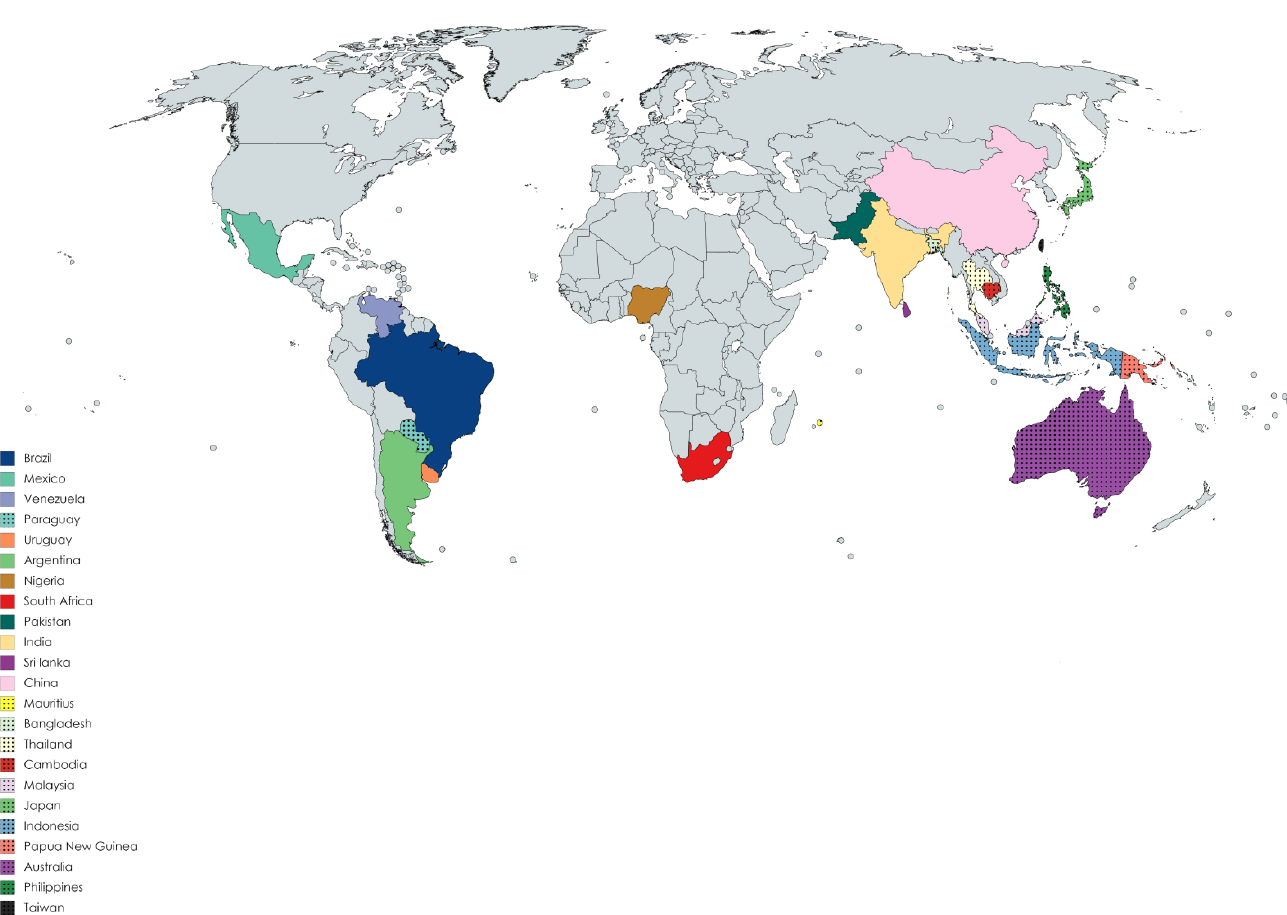
Figure 1. Ethnogeographical distribution of Mimosa